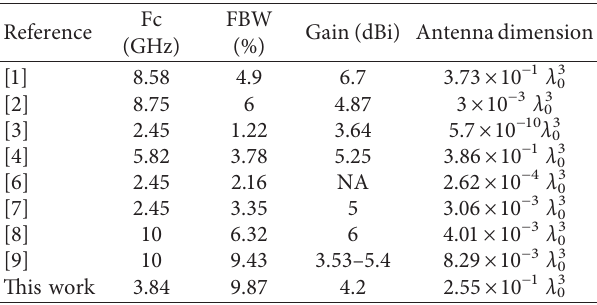
Table 1: Comparison with previous studies with respect to the bandwidth enhancement of the CBS antenna.